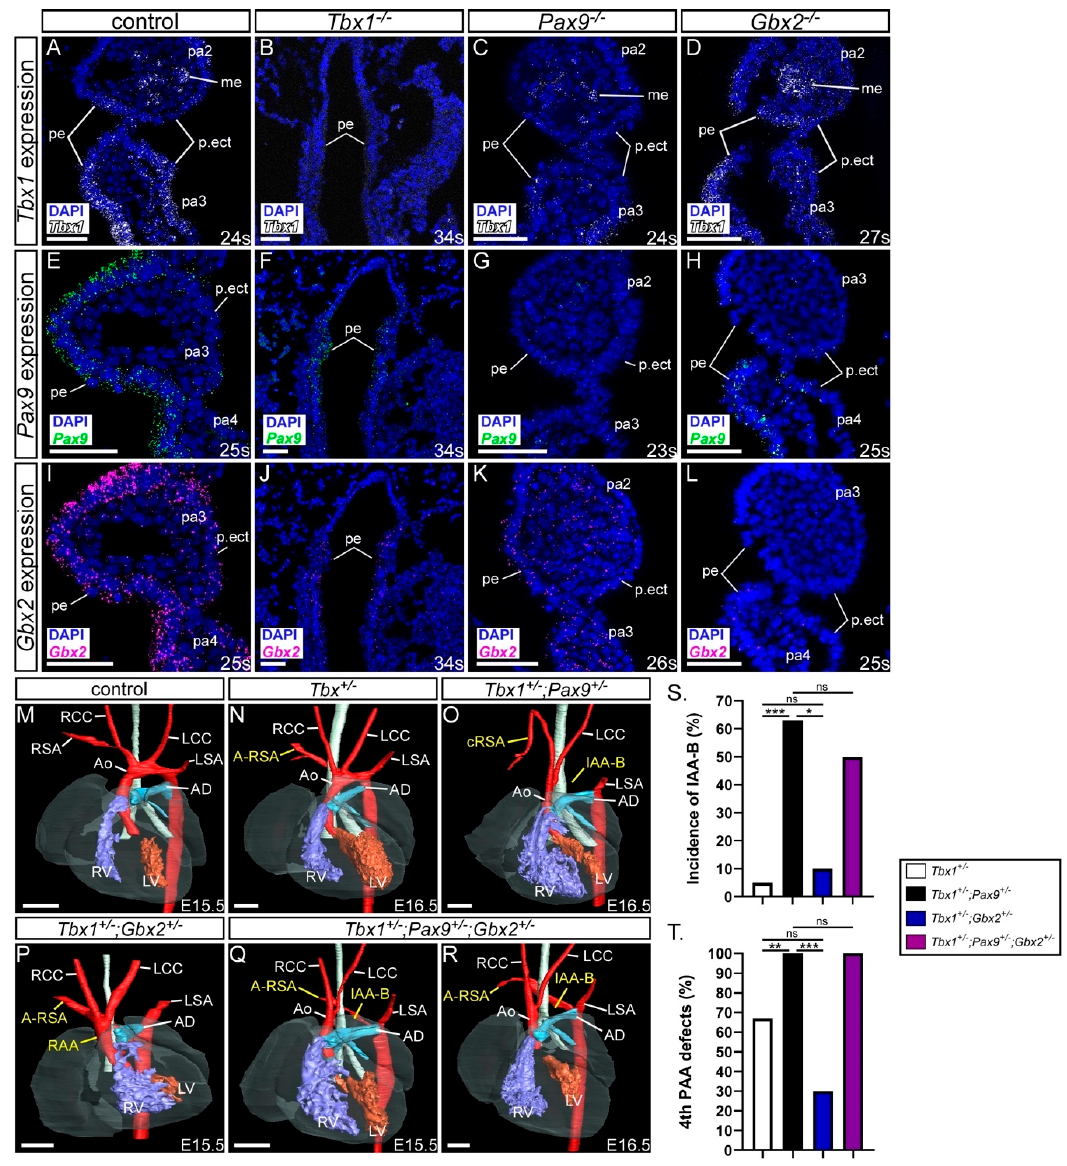
Figure 8. Gbx2 heterozygosity does not modify the Tbx1;Pax9 double heterozygous phenotype. ( A-L ) Tbx1 , Pax9 and Gbx2 expression in E9.5-E10.5 control and Tbx1 –/– , Pax9 –/– and Gbx2 –/– embryos (n ≥ 3 embryos per probe; 23–34 somites). ( A ) Tbx1 is expressed in the pharyngeal endoderm, mesoderm and ectoderm in control embryos. Tbx1 expression is absent in Tbx1 –/– embryos ( B ), reduced in Pax9 –/– embryos ( C ), and normal in Gbx2 –/– embryos ( D ). ( E ) Pax9 is expressed in the pharyngeal endoderm in control embryos. Pax9 expression is reduced in Tbx1 –/– embryos ( F ), absent in Pax9 –/– embryos ( G ), and present in Gbx2 –/– embryos ( H ). ( I ) Gbx2 is expressed in the pharyngeal endoderm in control embryos. Gbx2 expression is reduced in Tbx1 –/– embryos ( J ), reduced in Pax9 –/– embryos ( K ), and absent in Gbx2 –/– embryos ( L ). ( M–R ) 3D reconstructions of E15.5–16.5 hearts from µCT datasets. ( M ) Control embryo with normal heart and aortic arch arteries. ( N ) Tbx1 +/– embryo with aberrant right subclavian artery (A-RSA). ( O ) Tbx1 +/– ; Pax9 +/– embryo with interrupted aortic arch type B (IAA-B) and cervical origin of the right subclavian artery (cRSA). ( P ) Tbx1 +/– ; Gbx2 +/– embryo with a right-sided aortic arch (RAA) and A-RSA. ( Q, R ) Tbx1 +/– ; Pax9 +/–+/– ; Gbx2 +/– embryos with IAA-B and A-RSA. ( S,T ) Graphical representation of IAA-B incidence ( S ) and 4th pharyngeal arch artery (PAA) incidence ( T ) in Tbx1;Pax9;Gbx2 embryos. * p < 0.05; ** p < 0.001; *** p < 0.0001; Pearson chi-squared test for